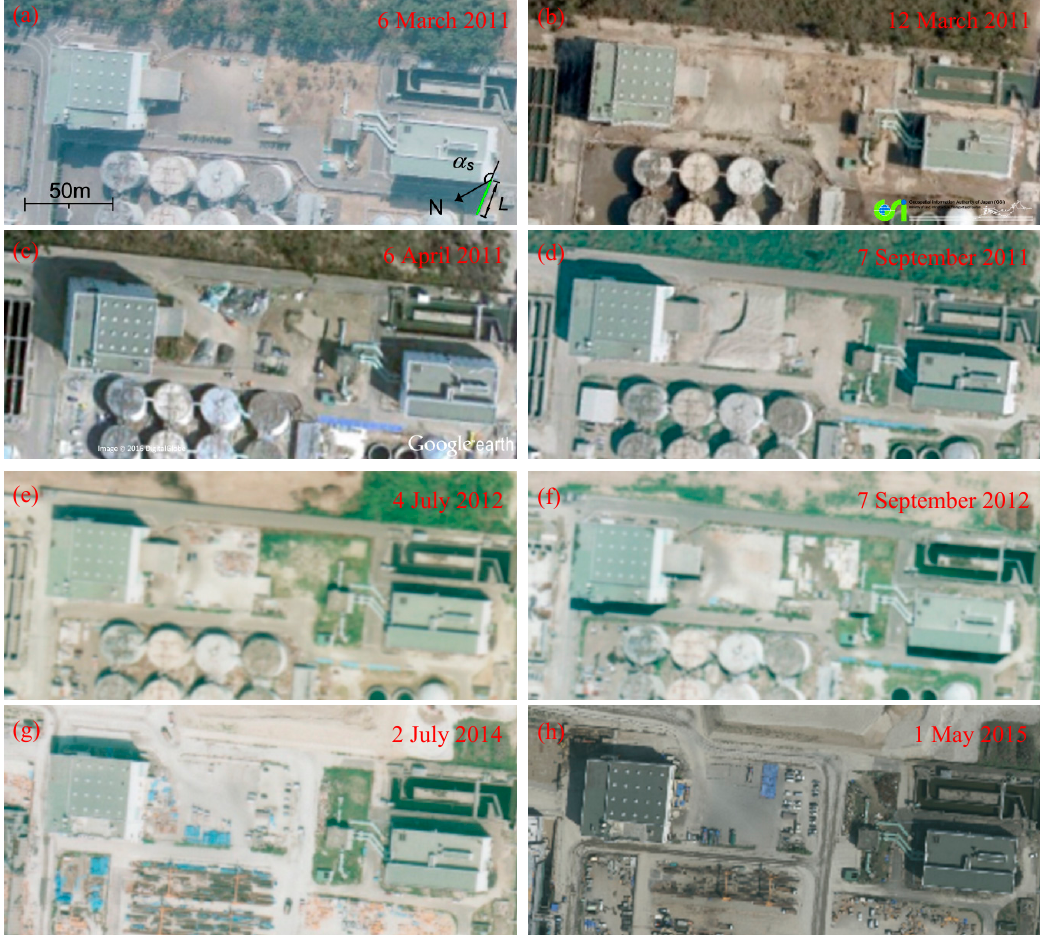
Figure 4. Measuring azimuth angle and length of shadow on aerial photographs and satellite images, ( a – h ) are the selected rectified images.